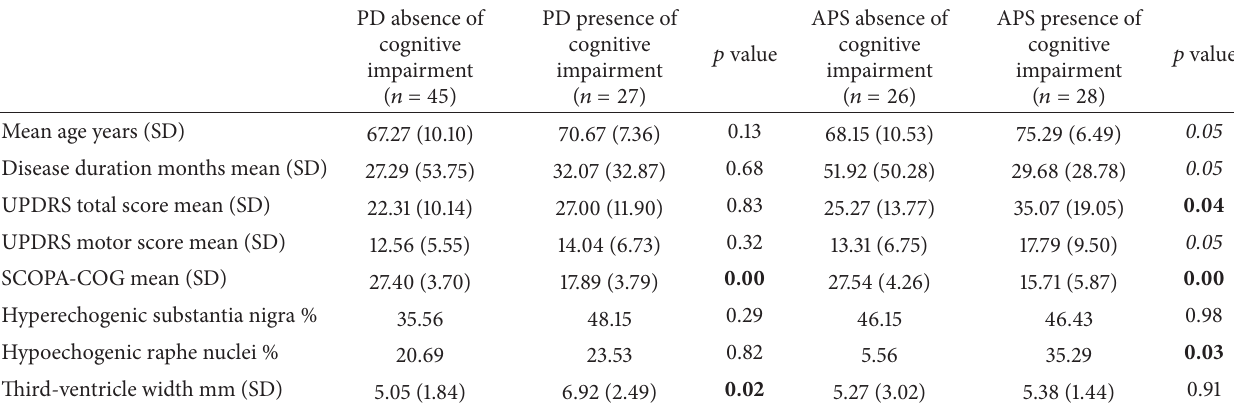
Table 2: Patient characteristics, divided into presence or absence of cognitive